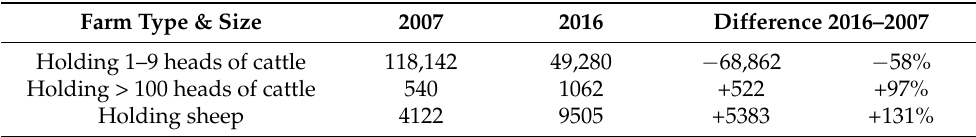
Table 2. Changes in numbers of farms holding livestock over the period 2007–2016 (Statistics Lithuania